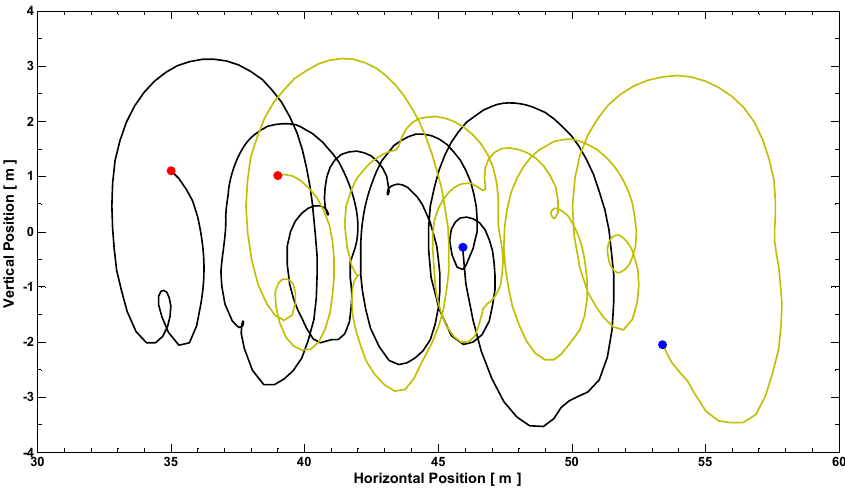
Figure 6. Examples of trajectories of foam particle. The particles move from left (red dots) to right (blue dots). Scale is distorted.